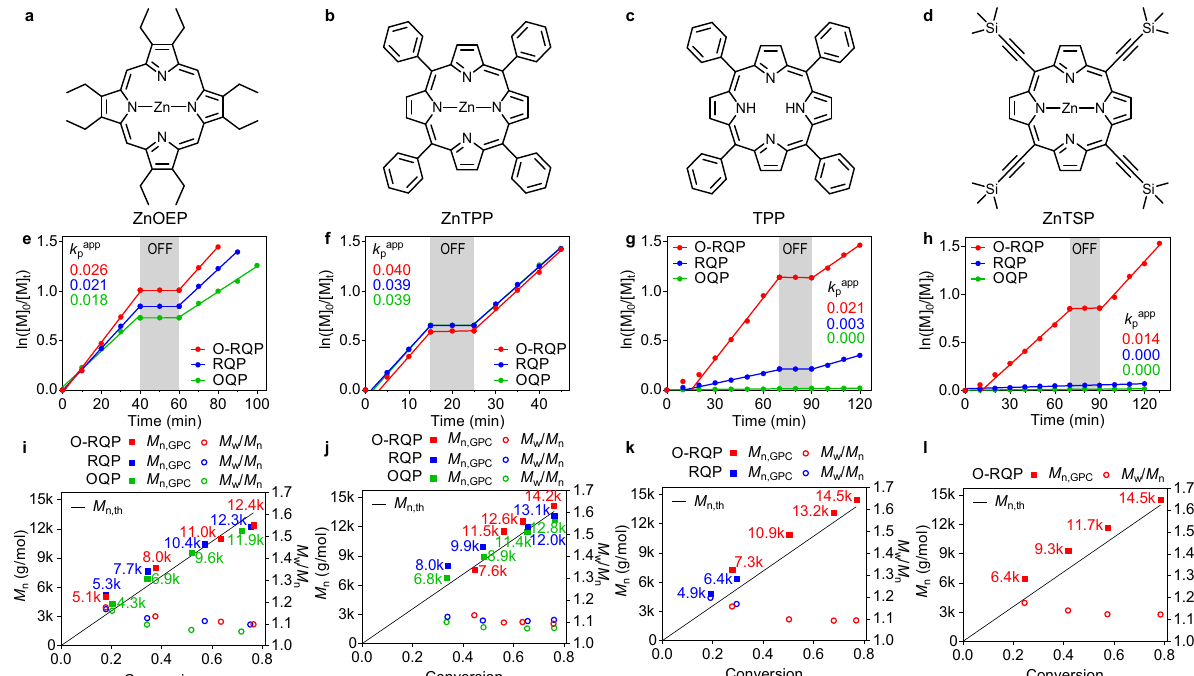
Fig. 2 Kinetic studies of PCs via different quenching pathways. a – d Molecular structures of ZnOEP ( a ), ZnTPP ( b ), TPP ( c ) and ZnTSP ( d ). e – h Plot of ln ([ M ] 0 /[ M ] t ) versus time revealing k p app and temporal control for model PET-RAFT polymerisation via OQP (green), RQP (blue) and O-RQP (red) catalysed by ZnOEP ( e ), ZnTPP ( f ), TPP ( g ) and ZnTSP ( h ) respectively. i – l M n (solid square) and M w / M n (hollow circle) versus monomer conversion analysed by gel permeation chromatography from aliquots taken at different time intervals during model PET-RAFT polymerisation via OQP (green), RQP (blue) and O-RQP (red) catalysed by ZnOEP ( i ), ZnTPP ( j ), TPP ( k ) and ZnTSP ( l ), respectively. The associated molecular weight distributions are provided in Supplementary Figs. 2 – 10. k p app apparent propagation rate of polymerisation, the number of which is denoted aside the corresponding polymerisation slope with the same colour. Average molecular weights M n were denoted aside the corresponding points in i – l with the same